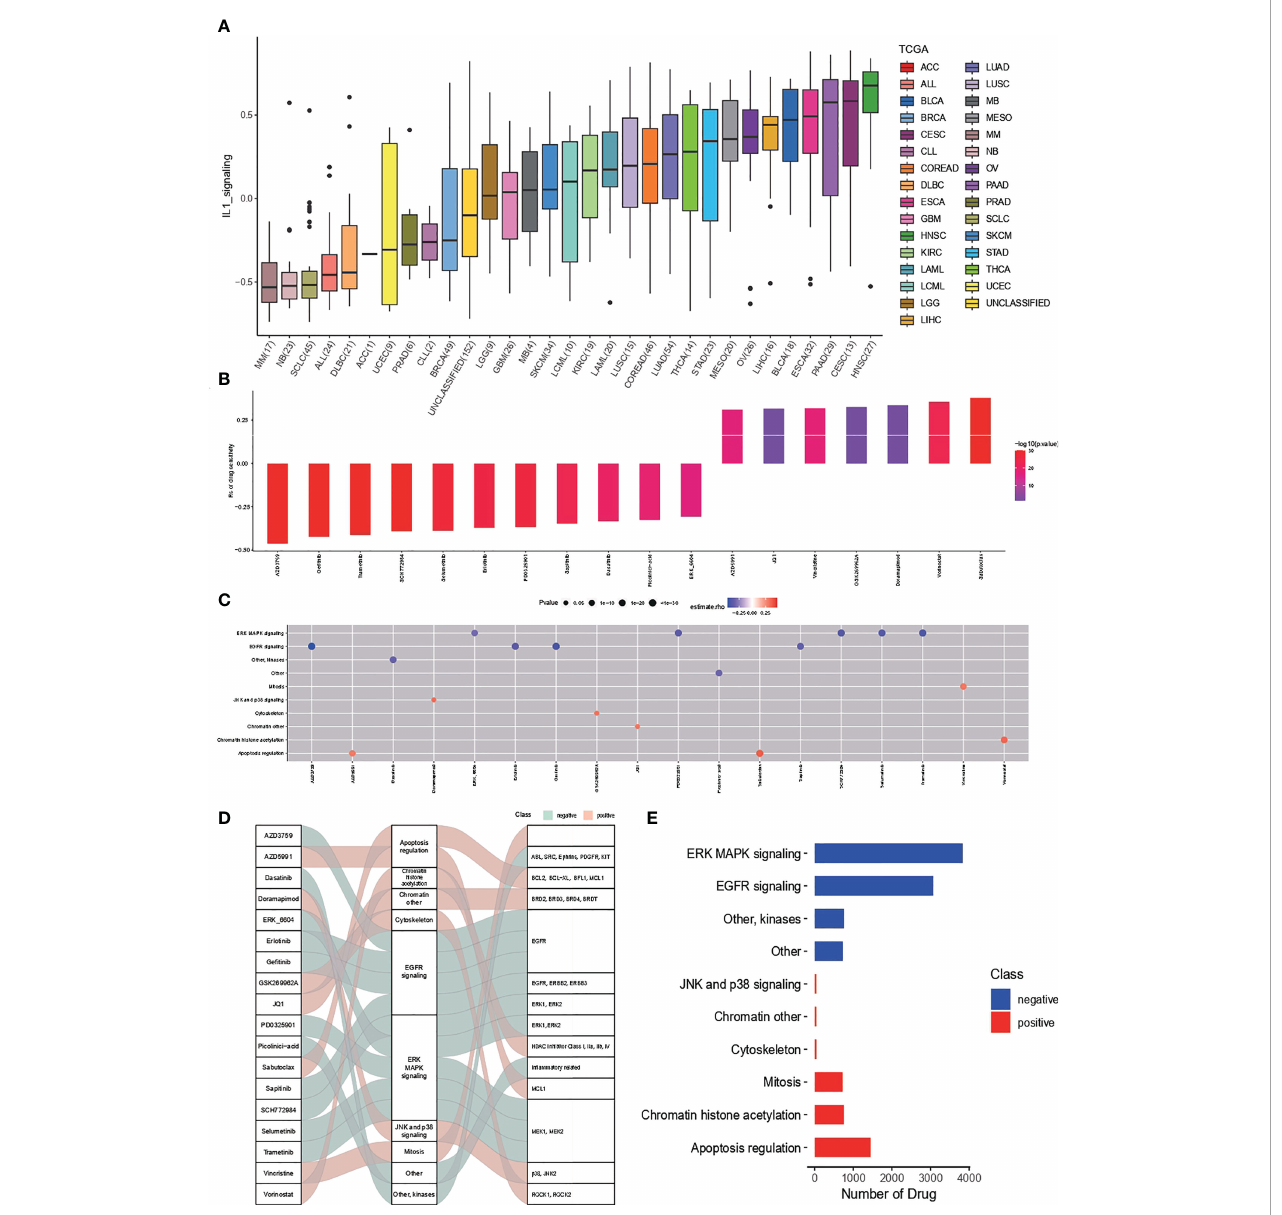
FIGURE 6 Drug sensitivity of IL-1score. (A) Distribution of IL-1score among different cancer cell lines in the GDSC cancer cell line database. (B, C) Drug sensitivity analysis screened for multiple drugs positively correlated with IL-1score scores. (D) Sankey diagrams of drugs with corresponding targets and pathways of action. (E) Major synergistic pathways between IL-1score and